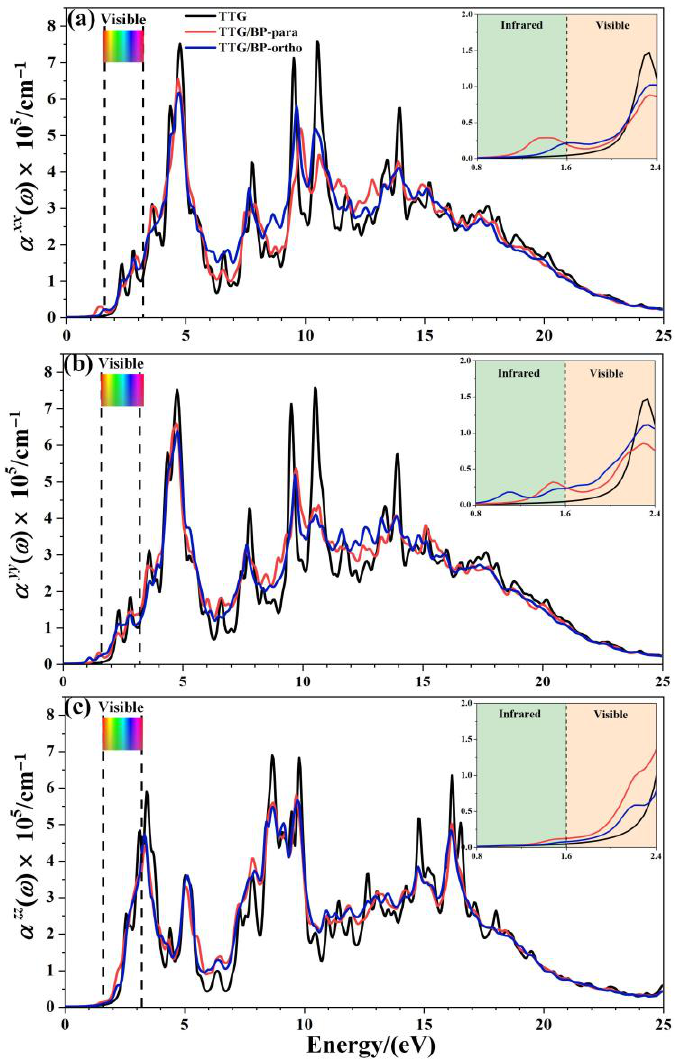
Figure 7. Absorption coefficient of pristine TTG and TTG/BP-4.2% systems. ( a ) α xx of TTG/BP-para-4.2%; ( b ) α yy of TTG/BP-para-4.2%; ( c ) α zz of TTG/BP-para-4.2%.